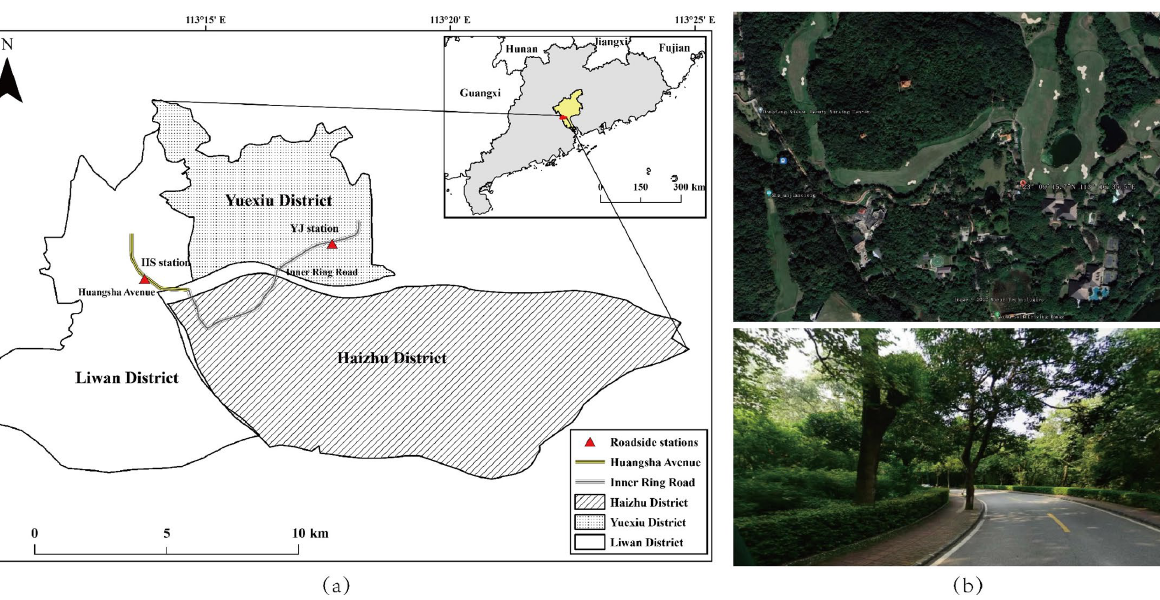
Figure 1. Overview of the study area and atmospheric monitoring stations. ( a ) Location of three stations; ( b ) Luhu station (LH); ( c ) Huangsha station (HS); ( d ) Yangji station (YJ). Meteorological data were obtained from Guangzhou Weather website (http://www.tqyb.com.cn/gz/weatherLive/autoStation/, accessed on 1 July 2021), includ- ing ambient temperature, wind speed, wind direction, solar radiation, and RH. The dy- namic traffic data were obtained from the Guangzhou Municipal Bureau of Transporta- tion (http://jtj.gz.gov.cn/jtcx/lkcx/, accessed on 1 July 2021). All the data were quality-con- trolled and covered the period from January to June 2021. 2.2. Analysis Approaches A stepwise regression model was used to investigate the relationship between the potential impact factors and O 3 concentration. Stepwise regression analysis automatically selects the most important variables to establish a predictive or explanatory model. The